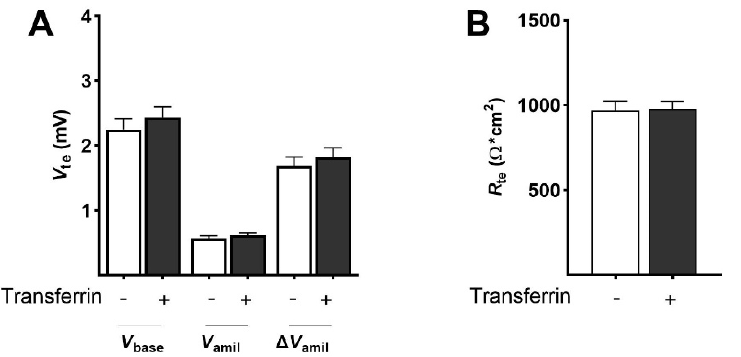
Figure 9. Transferrin has no effect on epithelial Na + transport and R te . FDLE cells were cultured in MEM and stimulated with transferrin (10 µg/mL) for 24 h. Data are displayed as mean + SEM. Transferrin had no effect on V base , V amil , Δ V amil ( A ) or R te ( B ) (n = 39–44).